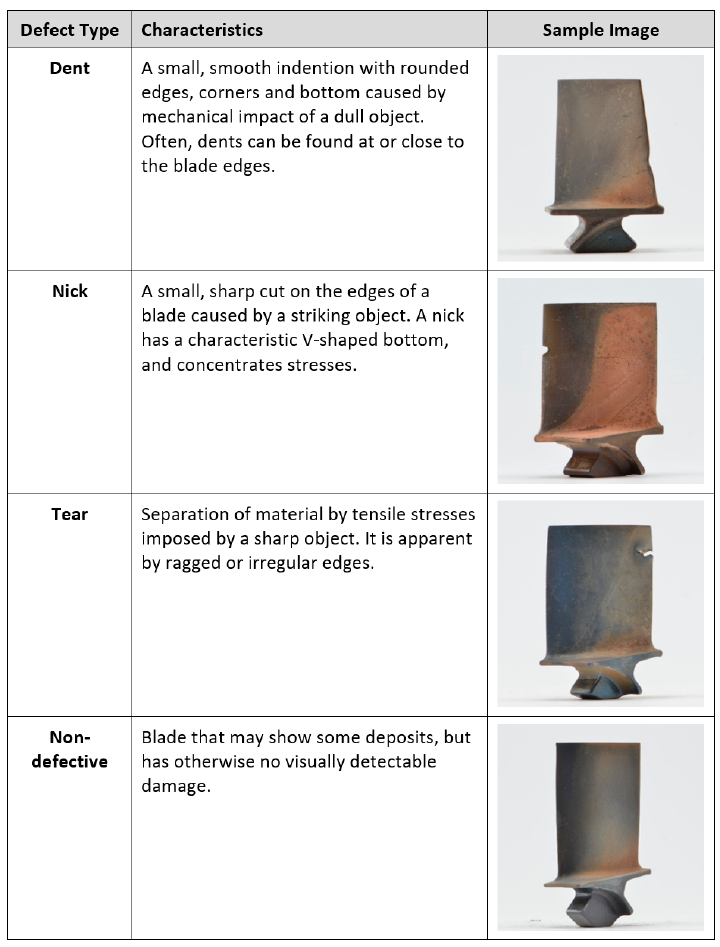
Figure 3. Overview of edge defects and their characteristics (Taxonomy adapted from [15]).